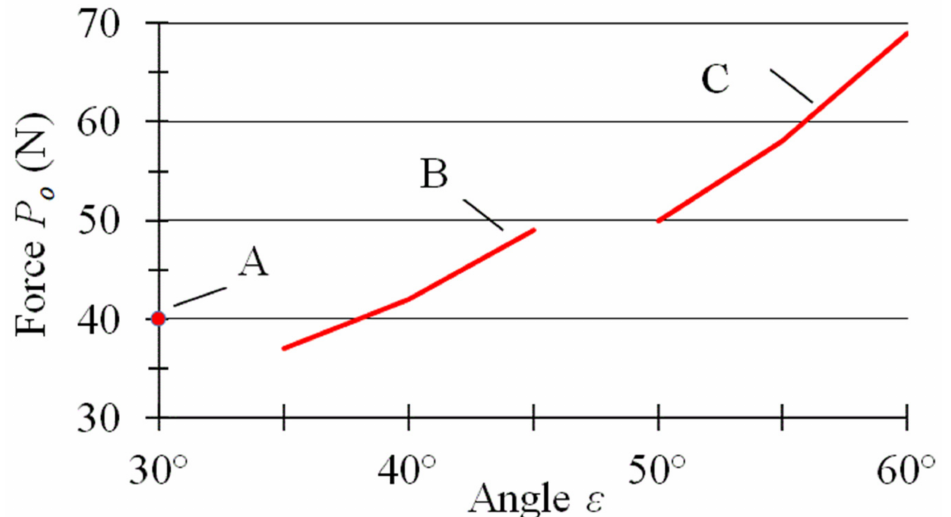
Figure 7. The dependence on the soil tillage resistance P o on the angle (cid:101) for the following values of the angle γ : 60 ◦ (point A); 45 ◦ (curve B); and 30 ◦ (curve